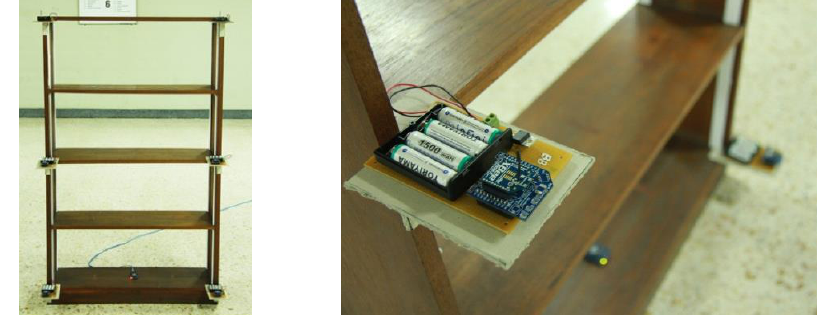
Figure 12. The real setup of 3D environment in a bookshelf.